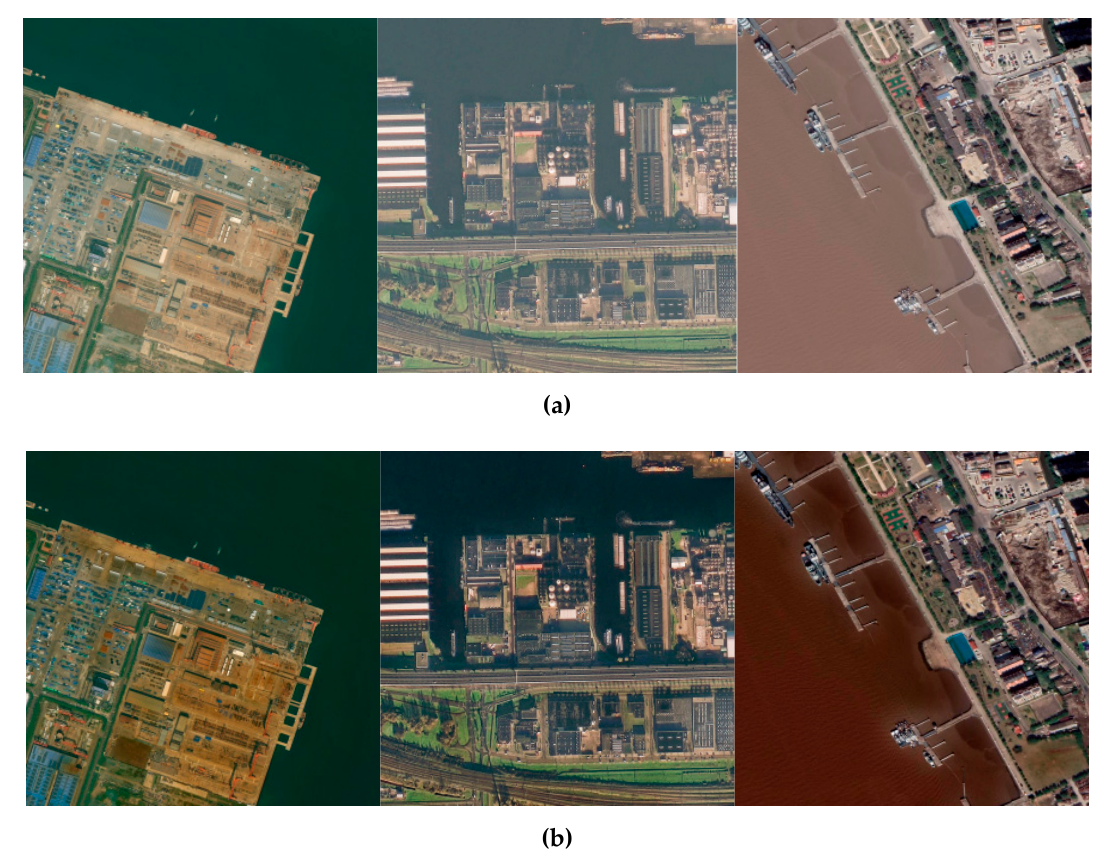
(b) Figure 3. Images before and after atmospheric correction: ( a ) images before correction; ( b ) corrected images.